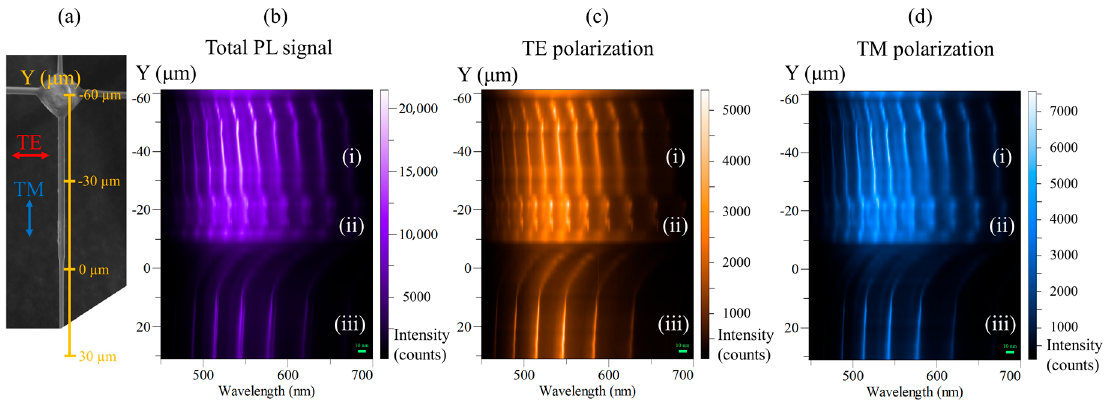
Figure 3. ( a ) SEM image of the selected rod, where the Y-axis scale used to perform the maps in ( b , c ) is shown. The directions of the transverse electric (TE) and transverse magnetic (TM) polarizations with respect to the c-axis of the structure are also indicated. ( b , c ) The maps of the evolution of the µ -PL emission along the Y-direction marked in ( a ): ( b ) total photoluminescence (PL) signal, ( c ) TE polarization, and ( d ) TM